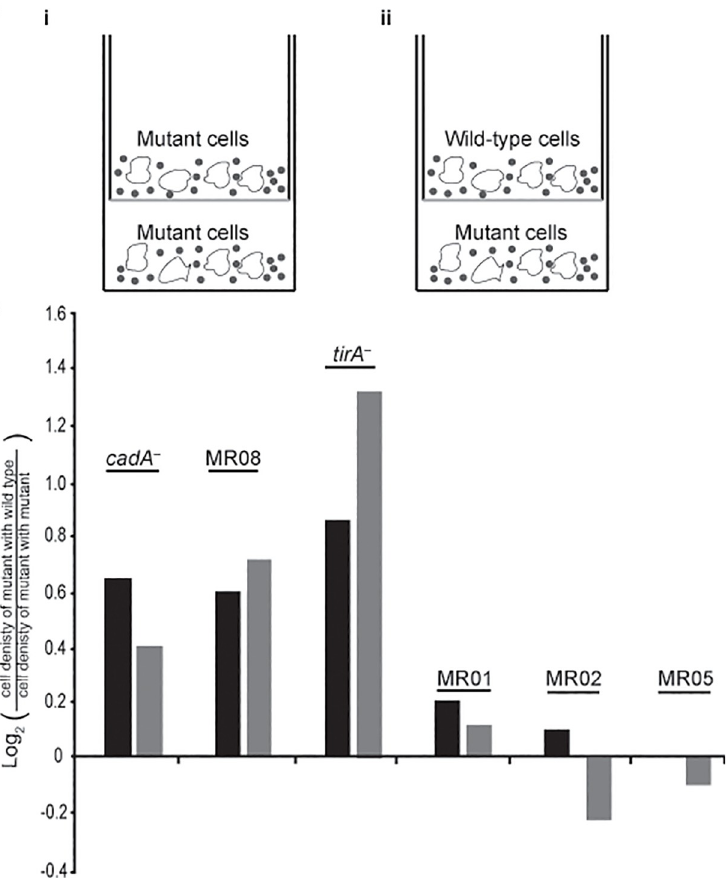
Fig 3. Cooperative growth is mediated by soluble factors. (a) We placed pure populations of wild-type and mutant cells at 2.5x10 4 cells/mL in submerged cultures in association with K . pneumoniae at the bottoms of two cell culture wells. We placed inserts in these wells, in which submerged cultures of amoebae (white shapes) and bacteria (black circles) were deposited on a membrane–one insert with matching mutant amoebae (i) and one with wild-type amoebae (ii). (b) We incubated the cells for 4-hours (black bars) and 8-hours (grey bars) and counted the mutant cells in the bottom wells. For each strain, we plotted (y-axis) the log 2 of the ratio between the mean mutant cell density in the presence of inserts containing wild-type cells (ii) and the mean mutant cell density in the presence of inserts containing mutant cells (i). We performed three independent replications for each experiment. A positive value indicates that the mutant grew more in the presence of wild-type cells. Strain names are indicated above the bars. Statistical significance is shown in S4 Fig.